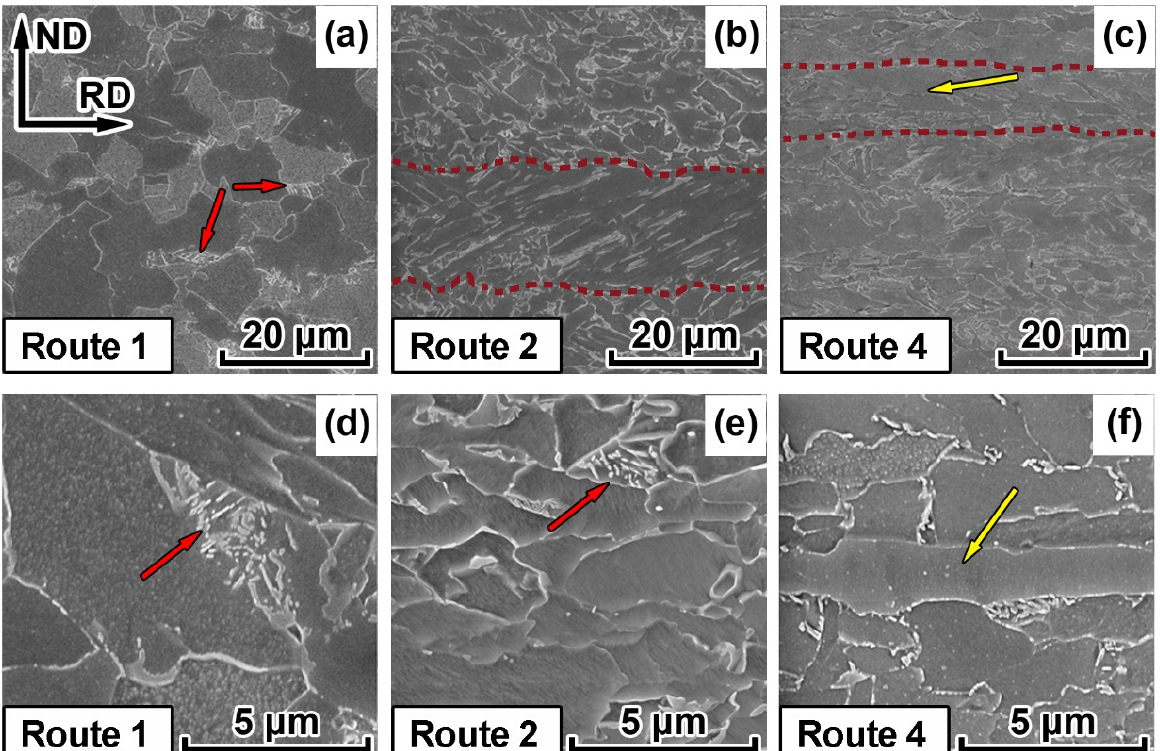
Figure 3. Scanning electron microscopy-backscattered electron (SEM-BSE) images of the central areas of the pipe steel plates after TMCP subjected to five routes: ( a , d ) route 1; ( b , e ) route 2; ( c , f ) route 4. Tempered martensite is marked with red arrows. Deformed ferrite grains are marked with yellow arrows. Red dotted lines indicate prior austenite grains.